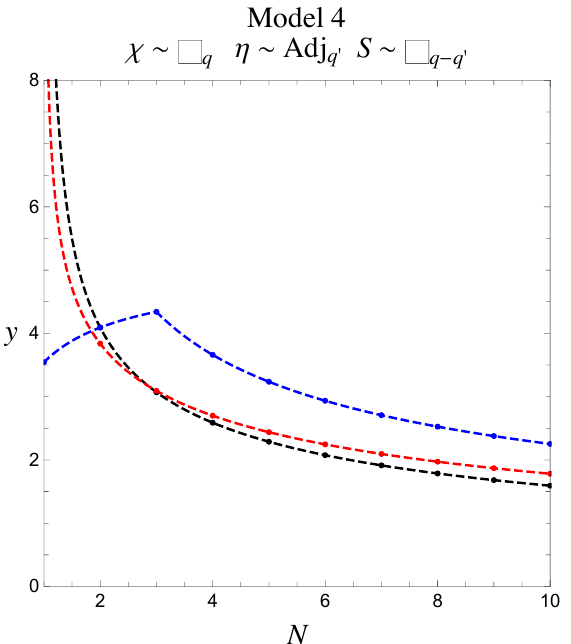
Figure 10 . PU bounds on the Yukawa couplings y for the model 4 of the Dirac type class for J = 0 (black), J = 1 / 2 (blue) and J = 1 (red). In this case the scalar is always a complex